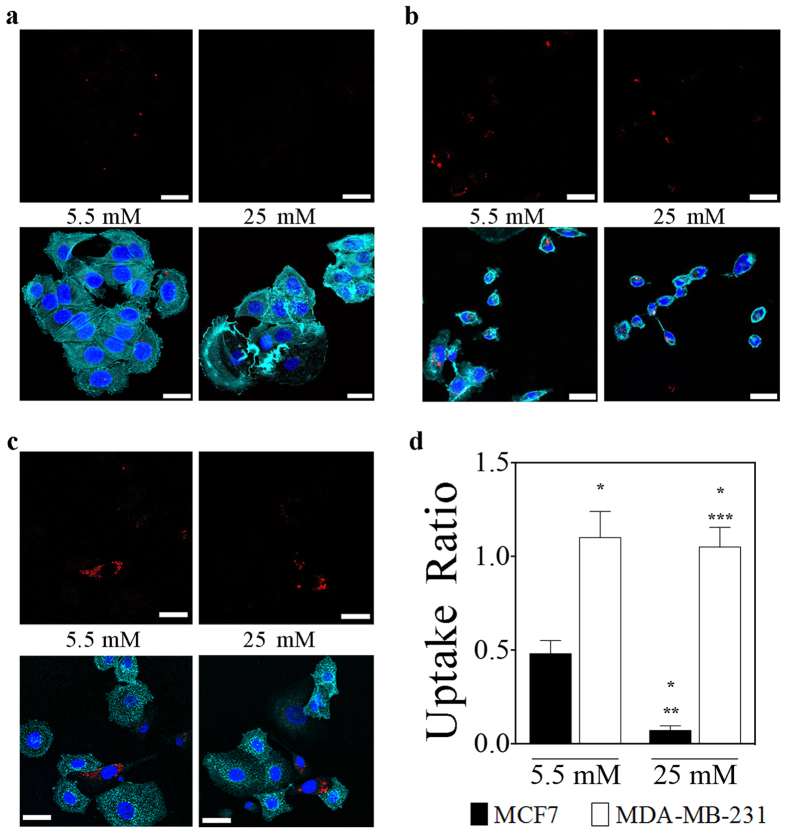
Glucose medium concentration discriminates between mesenchymal-like and epithelial-like breast cancer cells.Data were obtained analyzing by confocal microscope breast cancer cell lines treated with MNPs functionalized with 2-NBDG at the reported glucose concentrations. (a,b), Representative images of MCF7 (a) and MDA-MB231 (b) treated with 2.5 μg/mL CoFe2O4–2-NBDG NPs at both glucose medium concentrations. In the upper panels, MNPs are identified by the red fluorescence; in the lower panels, the localization of MNPs (red fluorescence) within the cells is confirmed by the presence of actin filaments (cyan fluorescence of rhodamine-conjugated phalloidin), and nuclei (blue fluorescence of DAPI). MCF7 cells exhibited a low uptake of 2-NBDG functionalized MNPs at 5.5 mM glucose concentration and quasi-null uptake ability at 25 mM glucose concentration. Conversely, MDA-MB-231 cells exhibited a quite constant uptake of 2-NBDG functionalized MNPs at both glucose concentrations. (c) representative image of a MCF7/MDA-MB231 co-culture sample; MNPs are evidenced in red while cyan fluorescence identifies the E-cadherin expression (epithelial marker) and nuclei are depicted by the blue fluorescence of DAPI. (d) Quantification of the CoFe2O4–2-NBDG NPs uptake by MCF7 and MDA-MB-231 cells, at both glucose medium concentration. Data are presented as mean ± standard deviation. *, **, ***p < 0.01 vs. the first, the second and the third column, respectively (One way Anova followed by post-hoc Bonferroni test). Scale bars: 50 μm.